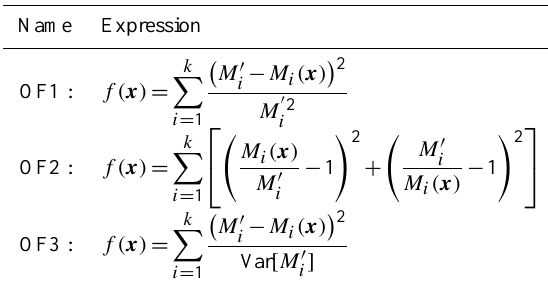
Table 2. Expressions of used objective functions for the calibration of the Modified Bartlett-Lewis